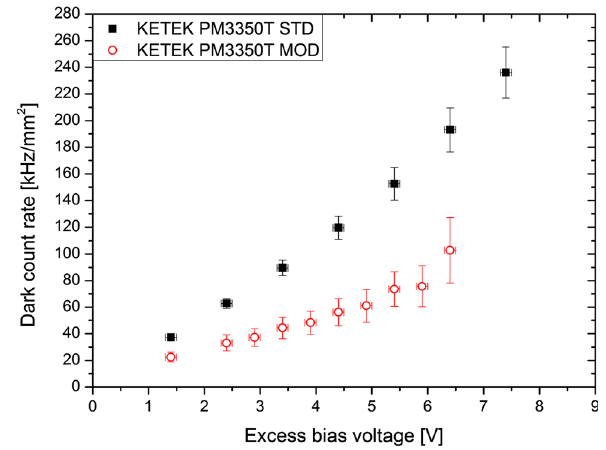
Fig. 15 Contribution R of hotspots to the overall DCR as a function of Δ V